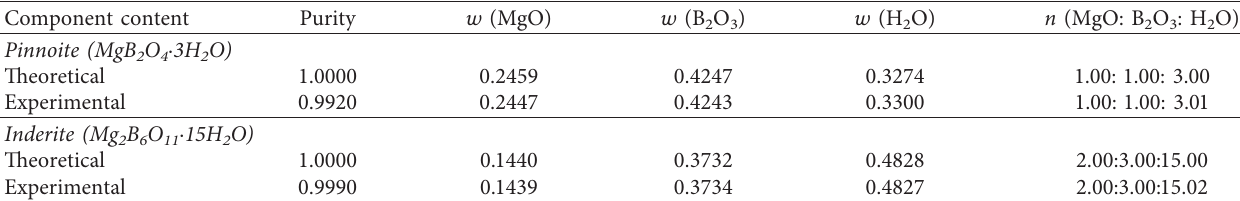
· 3H 2 O 4 2 O) and inderite (Mg 2 B 6 O 11